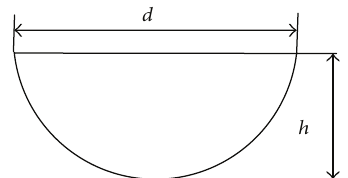
Figure 6: Sectional view of the dimple bionic nonsmooth symmetry plane.